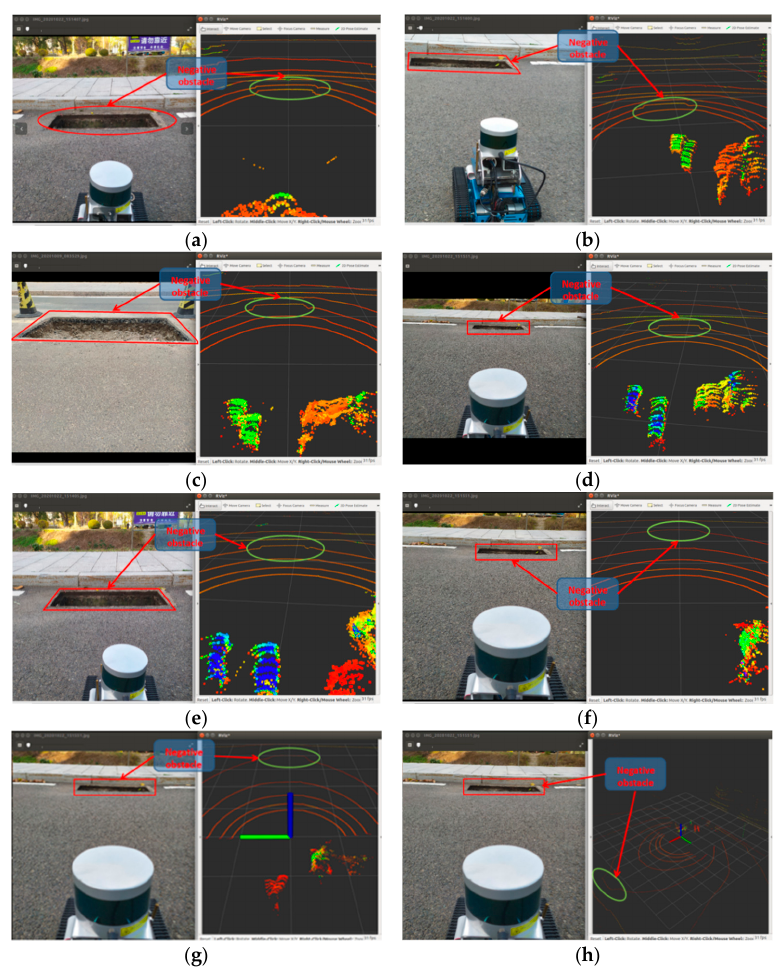
Figure 16 . Comparison of detection results at different distances. ( a ) 111.96 cm; ( b )129.94 cm; ( c ) 149.55 cm; ( d )189.41 cm; ( e ) 244.33 cm; ( f ) 324.90 cm; ( g ) 497.32 cm; ( h ) 1718.7 cm. Table 3. Experimental results of multidimensional, multi-group negative obstacle measurements.